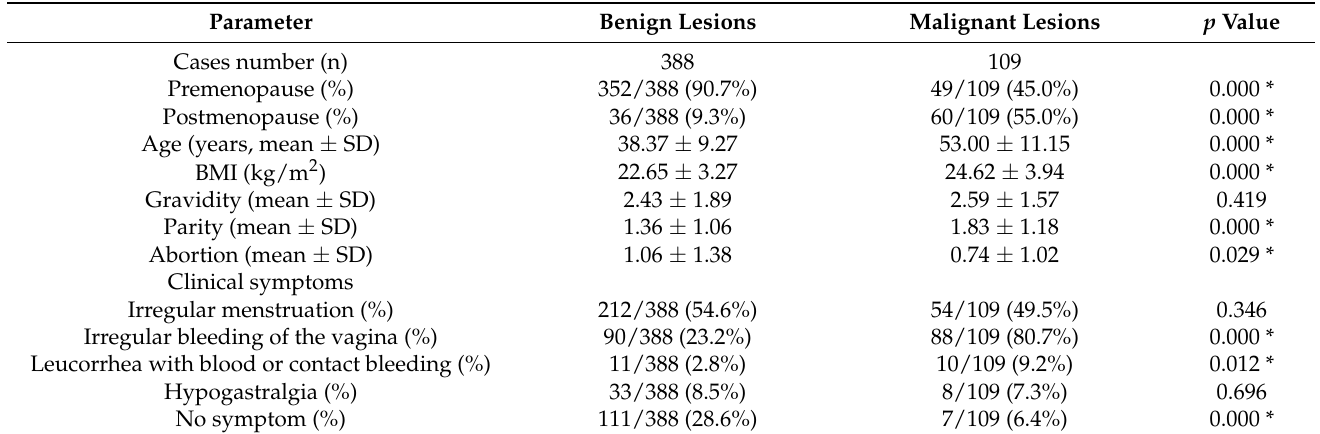
Table 5. Demographic and clinical variables of the study